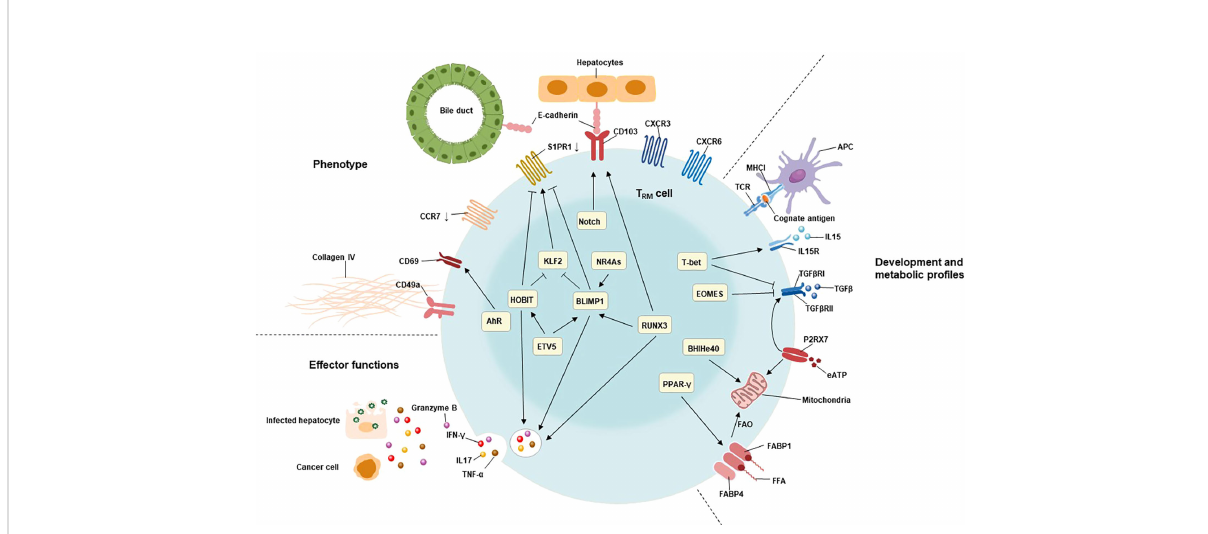
FIGURE 1 Characteristics of T RM cells include their tissue residency, long-term persistence, and effector function. The residency status of liver T RM cells is regulated by the combined action of B lymphocyte-induced maturation protein 1 (BLIMP1), BLIMP1 homolog in T cells (HOBIT), Notch, and runt-related transcription factor 3 (RUNX3). BLIMP1 and HOBIT downregulate CCR7, Krüppel-like factor 2 (KLF2) and tissue export pathway sphingosine 1-phosphate receptor 1 (S1PR1), while Notch directly upregulates the expression of CD103 on T RM cells. The interaction of CD103 and E-cadherin expressing on hepatocytes as well as cholangiocytes may be involved in adhesion and retention of hepatic T RM cells. Furthermore, the expression of BLIMP1 is regulated by the transcription factor runt-related transcription factor 3 (RUNX3) and NR4A family of orphan nuclear receptors (NR4As). The effector functions of liver T RM cells include direct killing of infected or malignant cells by secreting cytotoxic molecules and in fl ammatory cytokines, such as granzyme B, TNF- a , IFN- g , and IL17. The expression of these cytotoxic components is regulated by HOBIT, BLIMP1 and RunX3. The development and maintenance of T RM cells require stimulation with IL15, and TGF b , as well as cognate antigens presenting by antigen-presenting cells (APC). T-bet is essential for the sustain expression of IL15 receptor, albeit at low levels. Meanwhile, the expression of TGF b receptor is also regulated by P2X purinreceptor 7 (P2RX7), a sensor for extracellular nucleotides that promotes mitochondrial homeostasis. Mitochondrial fatty acid b -oxidation (FAO) is an important energy source for T RM cells. Peroxisome proliferator-activated receptor- g (PPAR g ) drives the upregulation of FABP1 and FABP4 to promote free fatty acid uptake from the extracellular compartment, while the transcription factor BHlHe40 maintains mitochondrial fi